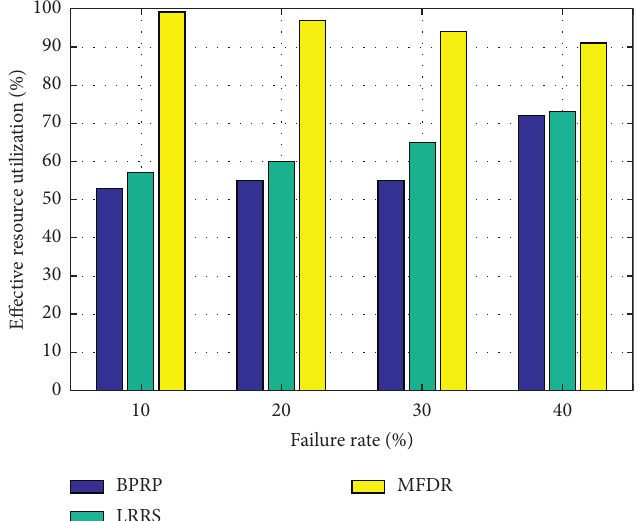
Figure 8: Relationship between effective resource utilization and failure